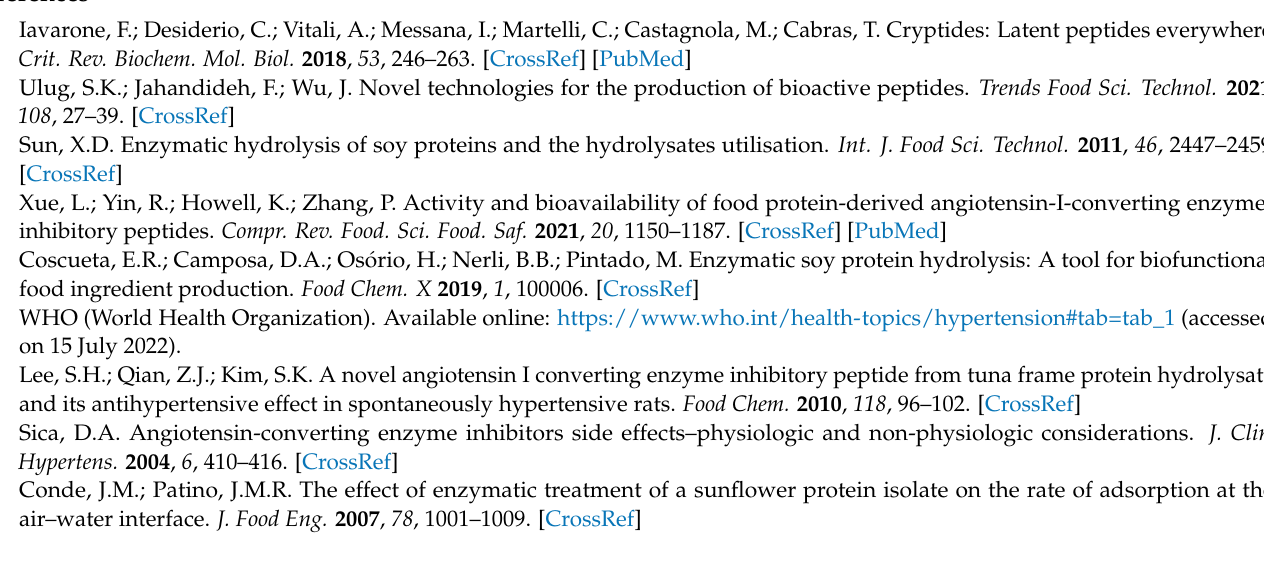
NDRP carried out in positive ion mode; Figure S14: 1H NMR (400 MHz) spectra of NDRP recorded High-resolution ESI mass spectra (positive ion mode) of NDRP; Figure S17: 13 C NMR (101 MHz) spectra of NDRP recorded in DMSO- d 6; Figure S18: High-resolution ESI mass spectra (positive ion mode) of NDRP; Table S1: L-Leu samples analysis for calibration curve; Table S2: AN L-Leu calibration curve; Table S3: Amino acids profile of SPI and N pb calculation; Table S4: Starting isolate soy proteins (SPI) and hydrolysates samples (A; F; A+F) analysis; Table S5: AN calculation; Table S6: DH calcula- tion; Table S7: Foaming capacity (FC) and foaming stability (FS) over time; Table S8: Amino acids profile of